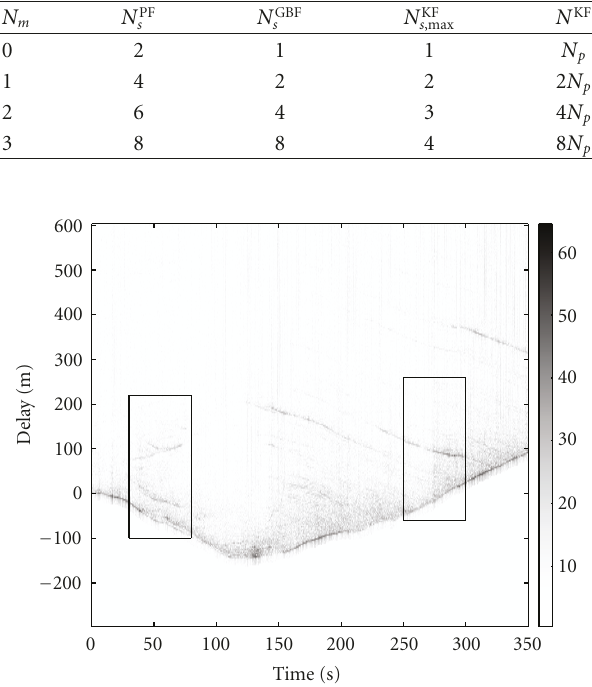
Figure 2: Typical satellite-to-pedestrian-user channel in an urban environment. The coloring indicates the power of the impinging wavefronts with respect to the receiver noise density in terms of C/N 0 . The boxes highlight the channel sections that are shown subsequently in Figures 6 and 7.